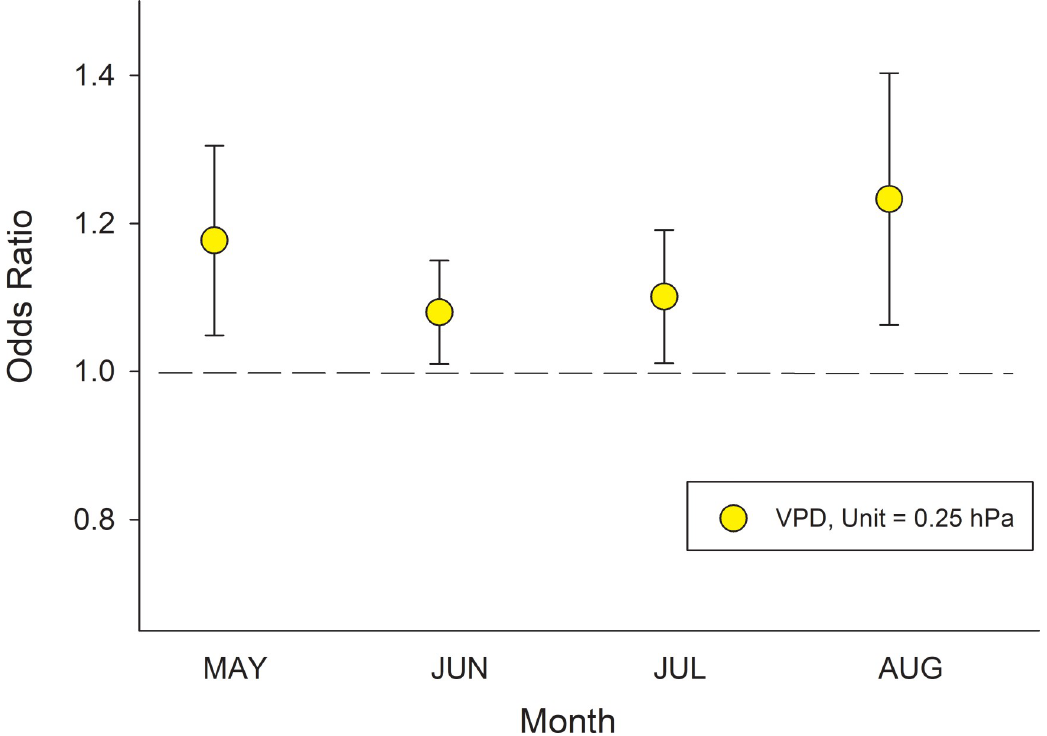
Fig 8. Modeling canker responses to variations in stand structure and climate. Odds ratios for canker incidence response to 0.25 hPa increases in VPD during May, June, July and August derived from the mixed-effects logistic equation model: Logit ( π ) = log ( π /(1- π )) = α + β 1 � DBH + β 2 � Relative Aspen Density + β 3 � Aspen Basal Area + β 4 � Mean Aspen DBH + β 5 � VPDmonth . Model results for stand structural variables and monthly VPD are show in S1 Table. Unit increases in variables with odds ratios above 1.0 significantly increase the probability of canker infection while those below 1.0 reduce the probability of canker infection. Thus, an odds ratio of 1.177 for VPD in May indicates that for every 0.25 hPa increase in VPD the odds of having canker increases by